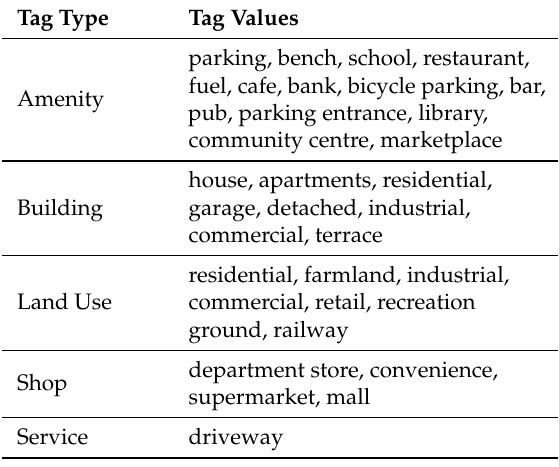
Table 3. OpenStreetMap (OSM) descriptive tags used to attribute the graph